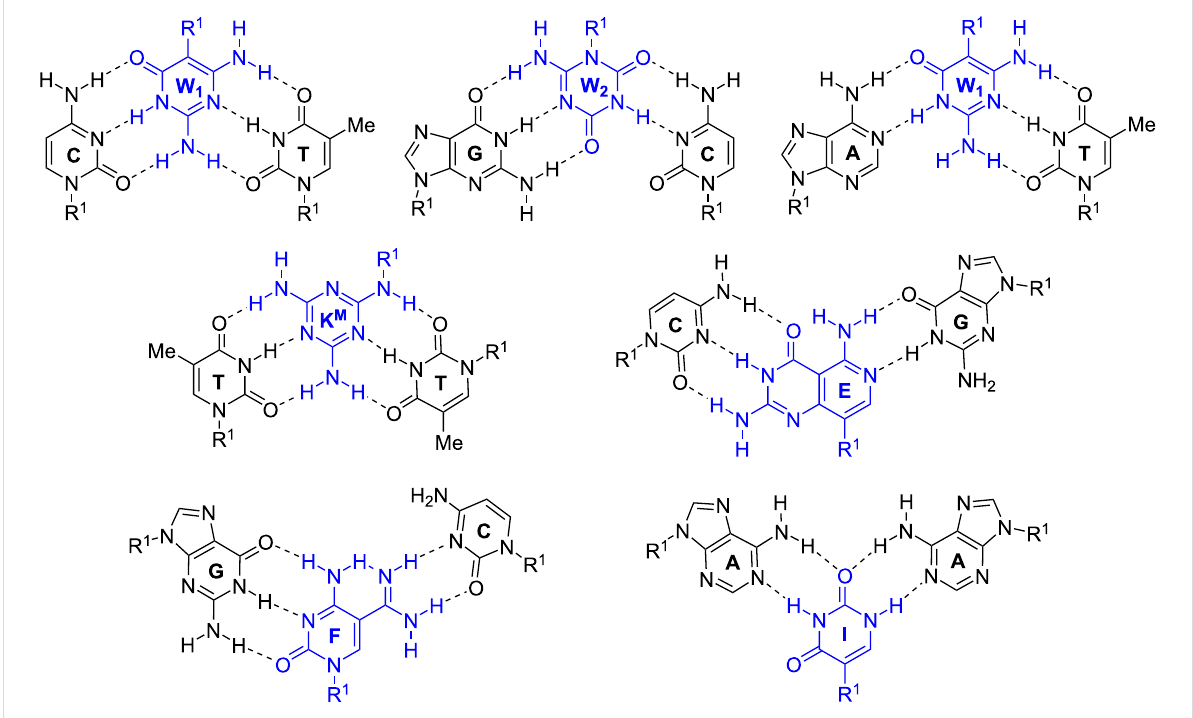
Figure 9: Examples of triplets formed by Janus-wedge PNA nucleobases (blue). R 1 denotes DNA, RNA, or PNA backbones.